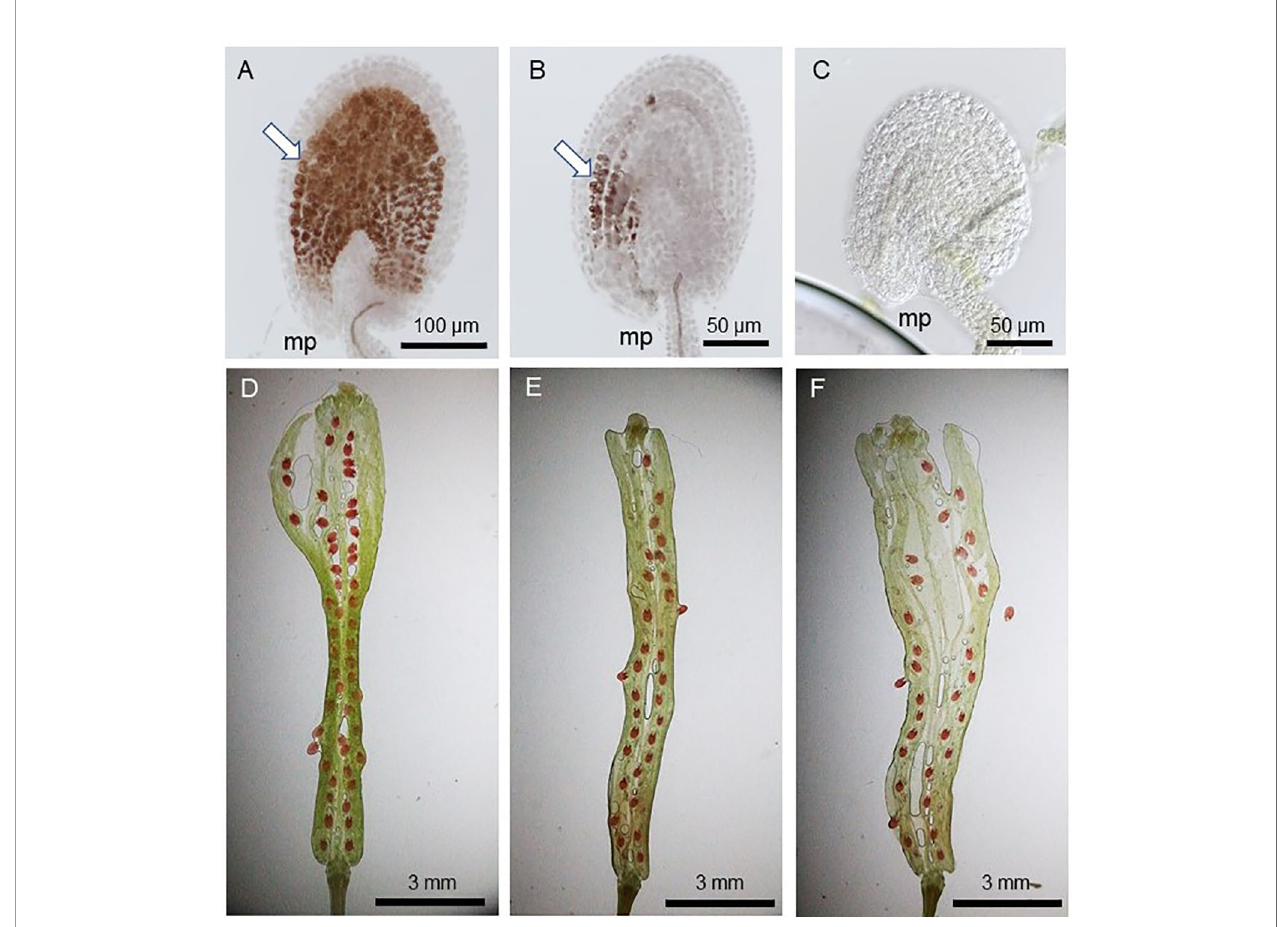
FIGURE 2 | Vanillin staining 3 days after pollination (DAP). (A) WT seed with full vanillin staining; (B) POEMed ovule with partial vanillin staining; (C) not pollinated ovule with no vanillin staining; (D) WT silique with ~100% seed-set (1:0:0 full:partial;no vanillin staining); (E, F) gcs1/+ self-pollinated silique with 60 – 75% seed-set (~3:1:0 full:partial:no vanillin staining); White arrows in (A, B) show the vanillin stains. mp =